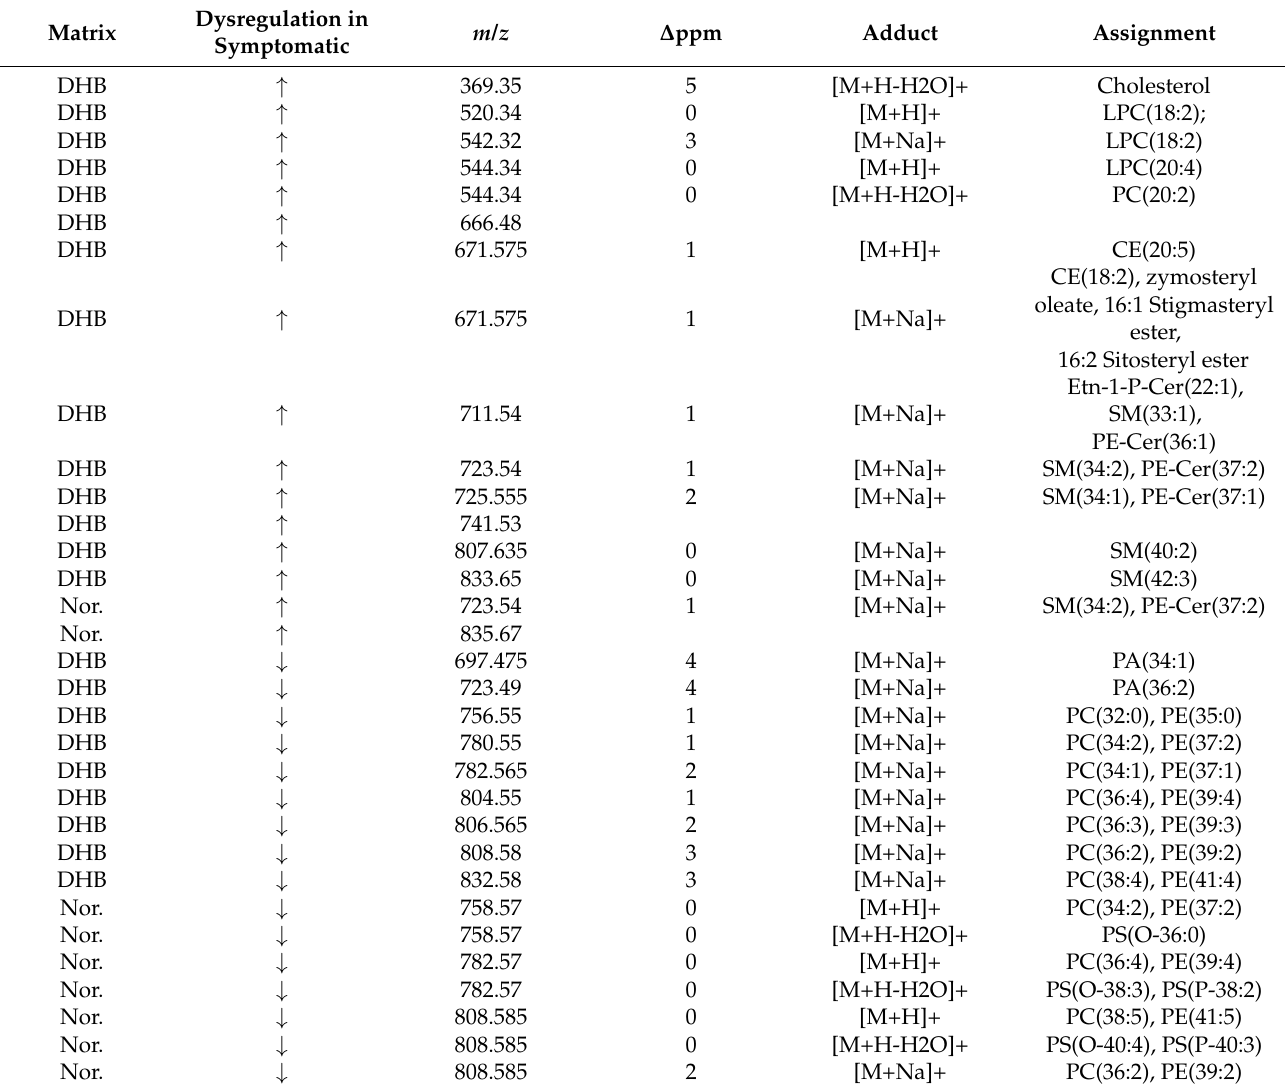
Table 1. Dysregulated lipids in the macrophage region of symptomatic plaques. Species with a VIP score greater than one and with a loading on the first PLS axis exceeding the 90th percentile of the positive or negative values are reported. Matrix